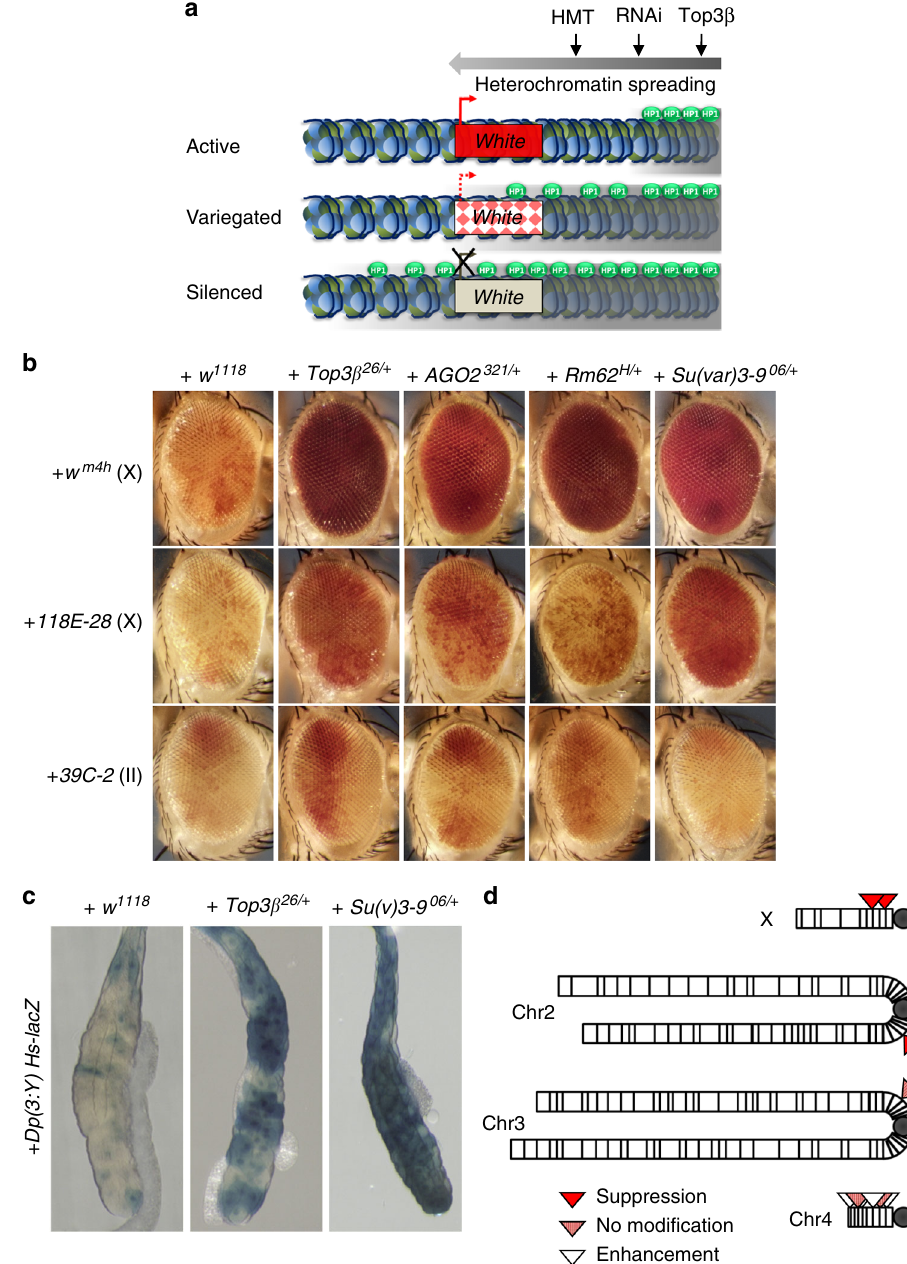
Fig. 3 Top3 β and RISC mutants are similar in disrupting heterochromatic gene silencing by PEV assay. a A cartoon illustrates the PEV assay using white gene as reporters. See Results for description. The heterochromatin is marked by gray area, whereas HP1 is marked by green balls. HMT denotes histone methyltransferase. b Representative eye images show that Top3 β is a suppressor of PEV similarly as are RISC components ( AGO2 and p68/Rm62 ), and Su (var)3-9 . Increased red color indicates suppression of silencing of white gene. Three white gene reporter lines were indicated on the left, with letters in parentheses indicating the chromosome with the reporter. Different mutant background is indicated on top. w 1118 serves as a negative control as Top3 β 26 was generated in its background. c A LacZ reporter-based PEV assay shows that Top3 β mutant suppresses PEV similarly as does Su(var)3-9 mutant. PEV suppression is indicated by increased blue color due to de-silencing of the LacZ. Su(var)3-9 06/ + served as a positive control, whereas w 1118 as a negative control, as indicated on top. d Schematic representation summarizing the PEV modi fi cations by Top3 β mutants for reporters located on different chromosomes. Note that Top3 β enhanced PEV for reporters in heterochromatin of chromosome 4, which is known to be different from those on heterochromatin